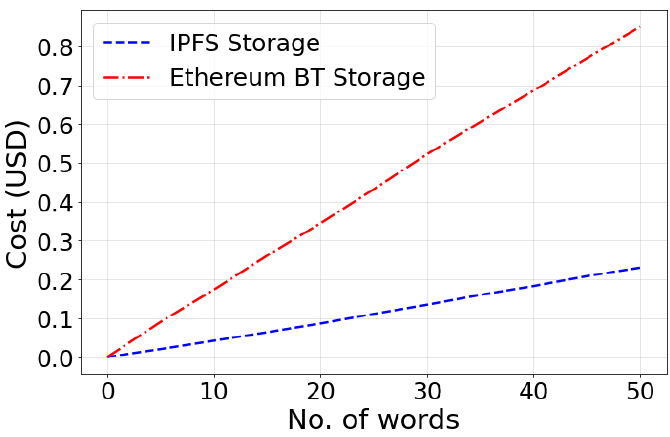
Figure 6. IPFS Storage